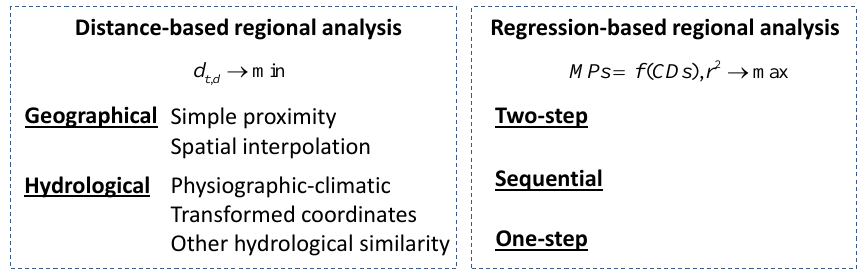
Fig. 1. The two categories of methods for regional estimation of continuous streamflow and the session structure of the paper.